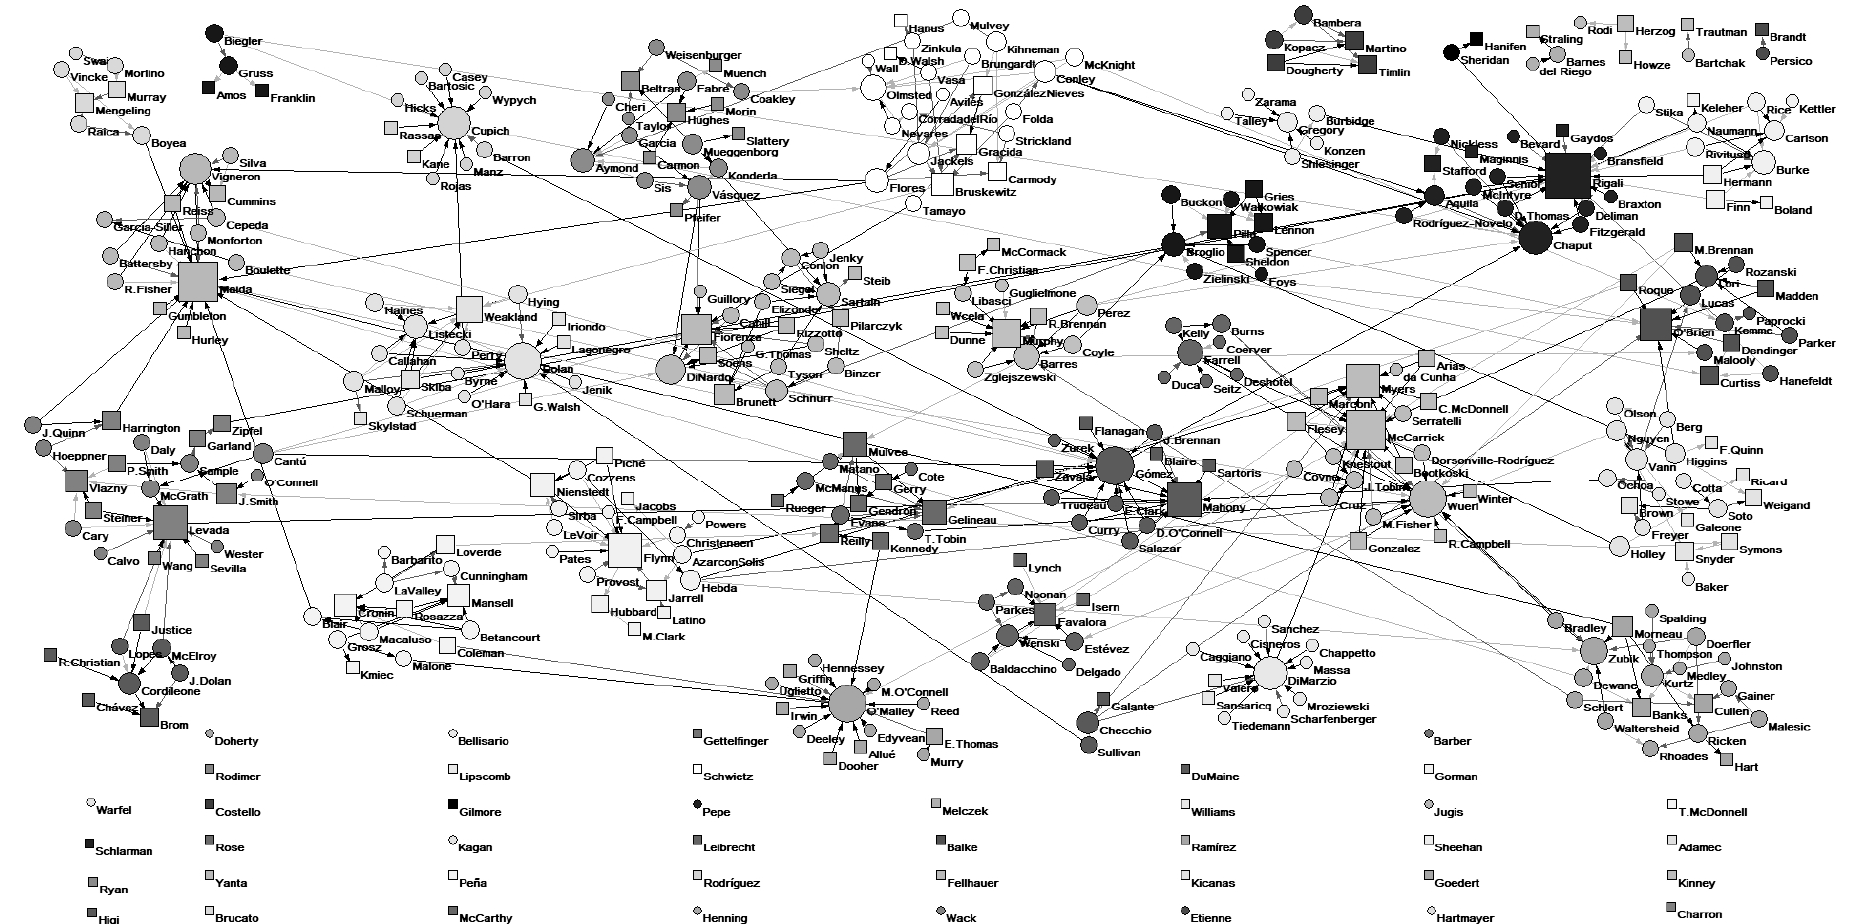
Figure 3. Visualization of US bishops’ network using VOS algorithm (July 2018).